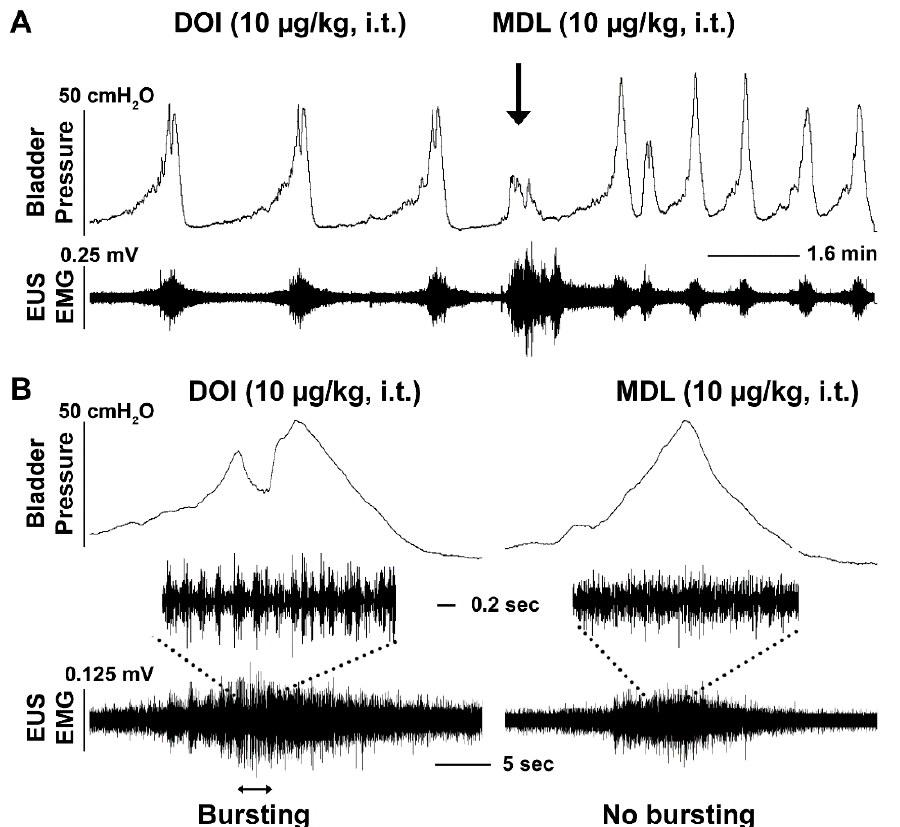
Figure 4. Intrathecal (i.t.) administration of MDL abolishes DOI induced excitatory effects on the EUS reflex in SCI rats. A representative cystometry and EMG trace demonstrates that MDL, a 5-HT 2A receptor antagonist (10 μ g/kg), shortens the VI ( p < 0.05, Friedman’s test followed by Dunn’s) ( A ) and masks bursting EUS activity ( B ), leading to the occurrence of detrusor ‐ sphincter dyssynergia.